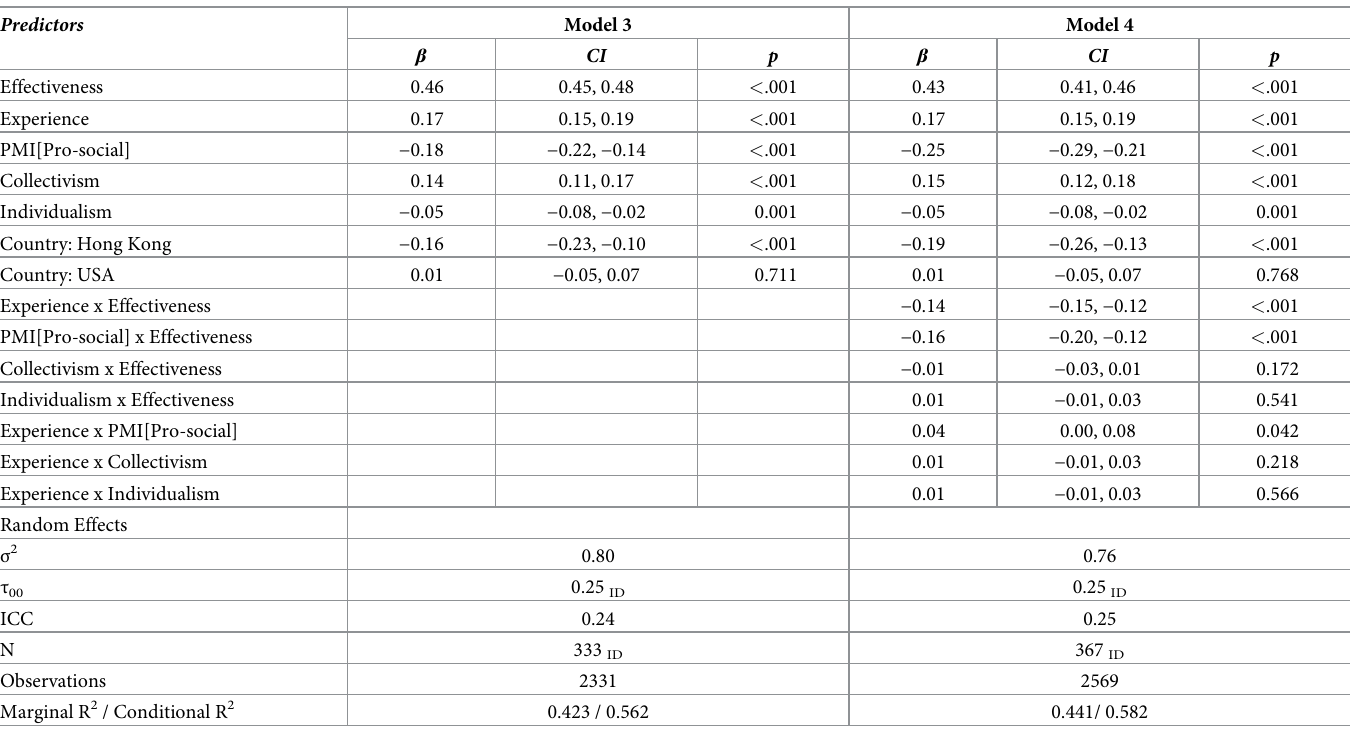
Table 2. Reproducing the models with the